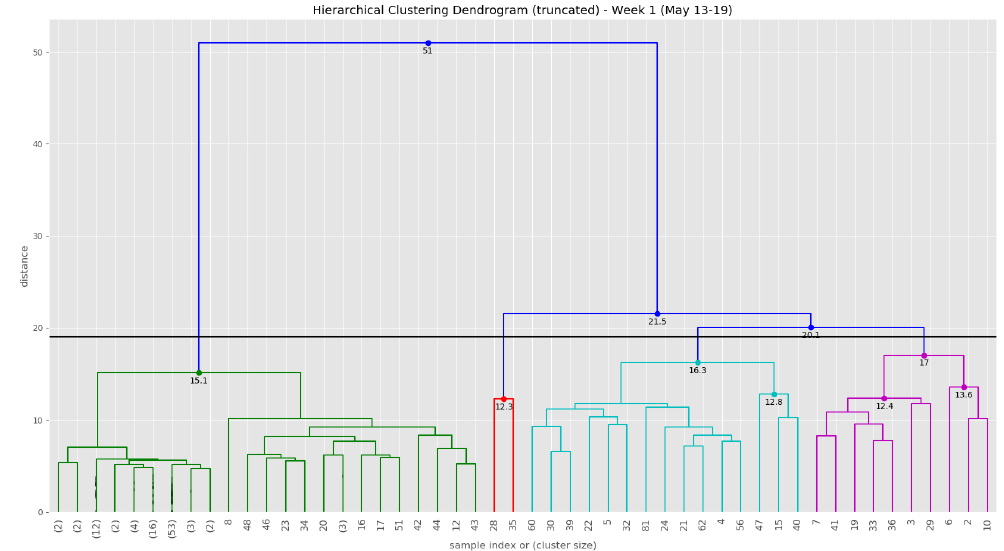
Figure 12. The dendrogram of the first observation week (13 May–19